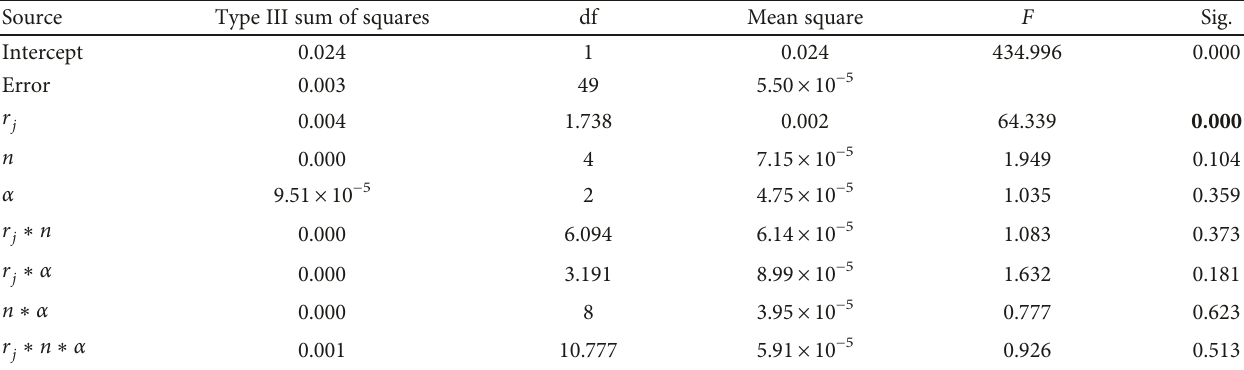
Table 6: Tests of between-subject e ff ects to the FLTPA heuristic ’ s error.